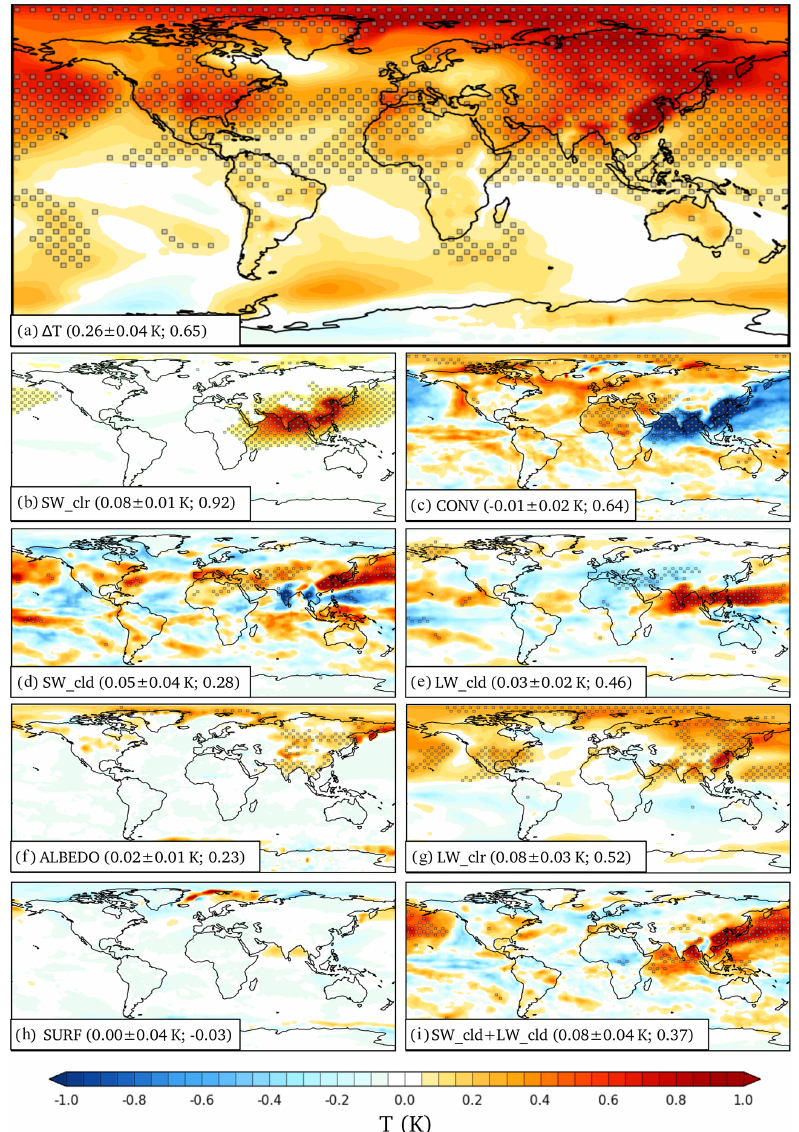
Figure 2. The geographical distributions of annually averaged surface air (2m) temperature responses due to the removal of South and East Asian aerosols (mean over ECHAM6.1 and NorESM1 climate models). Brackets show global average responses in kelvins and the model-to- model correlation coefficient, respectively. (a) The total surface temperature response. (b–h) Contributions to the total surface temperature response from shortwave clear-sky response (b) , horizontal atmospheric heat transport (c) , shortwave cloud response (d) , longwave cloud response (e) , surface albedo change (f) , longwave clear-sky response (g) , and surface energy flux change (h) . (b–h) Sum up to the response seen in panel (a) . Panel (i) shows the combined shortwave and longwave cloud response. Stippling shows regions where the results are statistically significant at the p < 0 . 05 level for both models, and models also agree on the